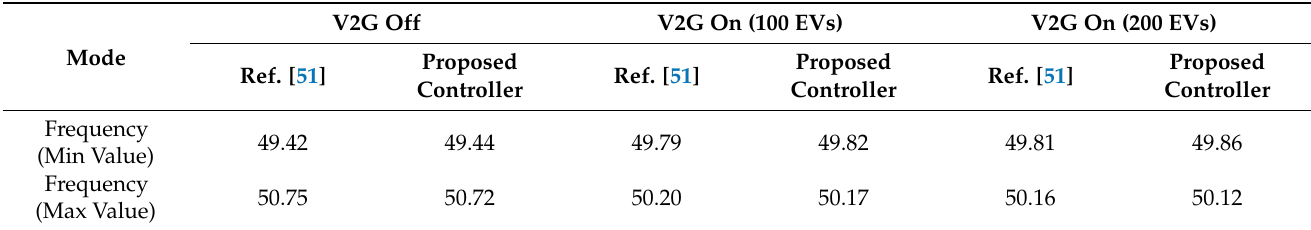
Table 4. Comparison of results for three separate cases in scenario 1 using the proposed controller compared to those of